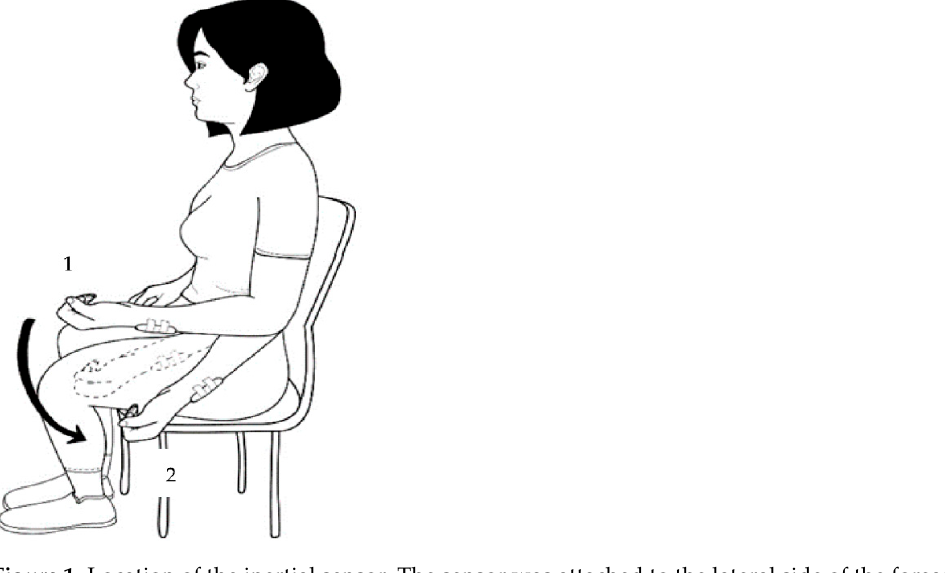
Figure 1. Location of the inertial sensor. The sensor was attached to the lateral side of the forearm: (1) starting position and (2) ending position. (1) starting position and (2) ending